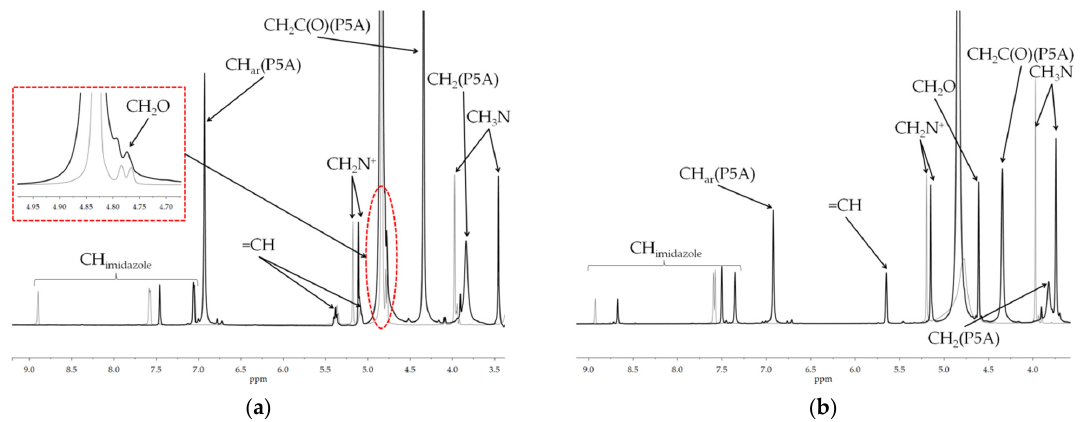
Figure 2. Fragments of 1 H-NMR spectrum of systems 4a/5 ( a ) and 4d/5 ( b ) (black) and meroterpenoids 4a and 4d (gray) in a CD 3 OD/D 2 O mixture (5 × 10 − 3 M) at 298 K, 400 MHz.